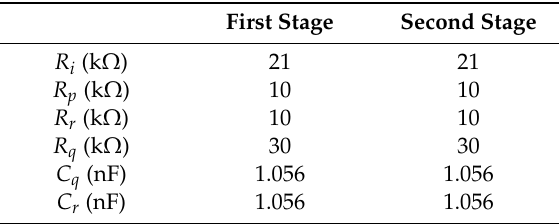
Figure 3. Schematic of the difference amplifier.